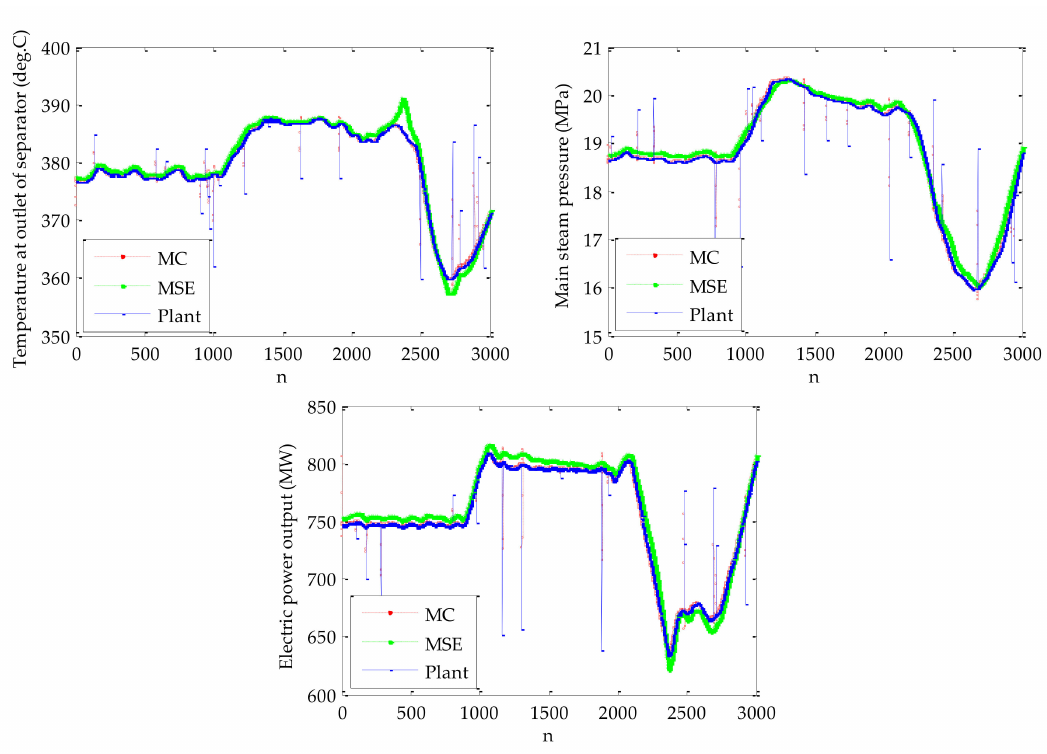
Figure 12. A comparison of SAE models using di ff erent loss functions without the preprocessing process (validating).